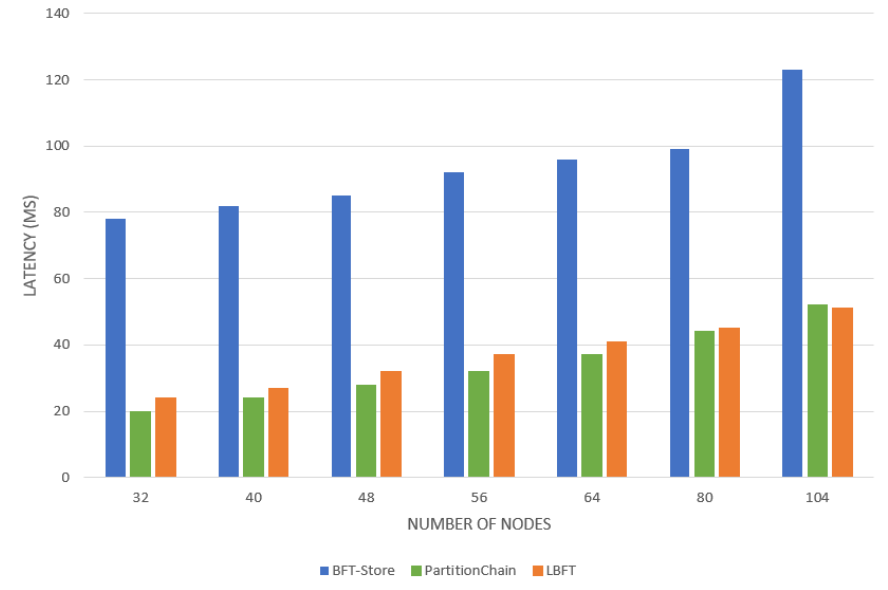
Figure 8. The latency in LBFT, PartitionChain, and BFT-Store against the number of nodes. As depicted in Figure 8, the latency increases slightly as the number of nodes rises in LBFT, PartitonChain, and BFT-Store. It is obvious that LBFT and PartitionChain share a similar latency, which is merely half of the latency in BFT-Store. For example, when the number of nodes is 56, the latency in LBFT is about 39.2 ms, while the latency in BFT-Store reaches 92.1